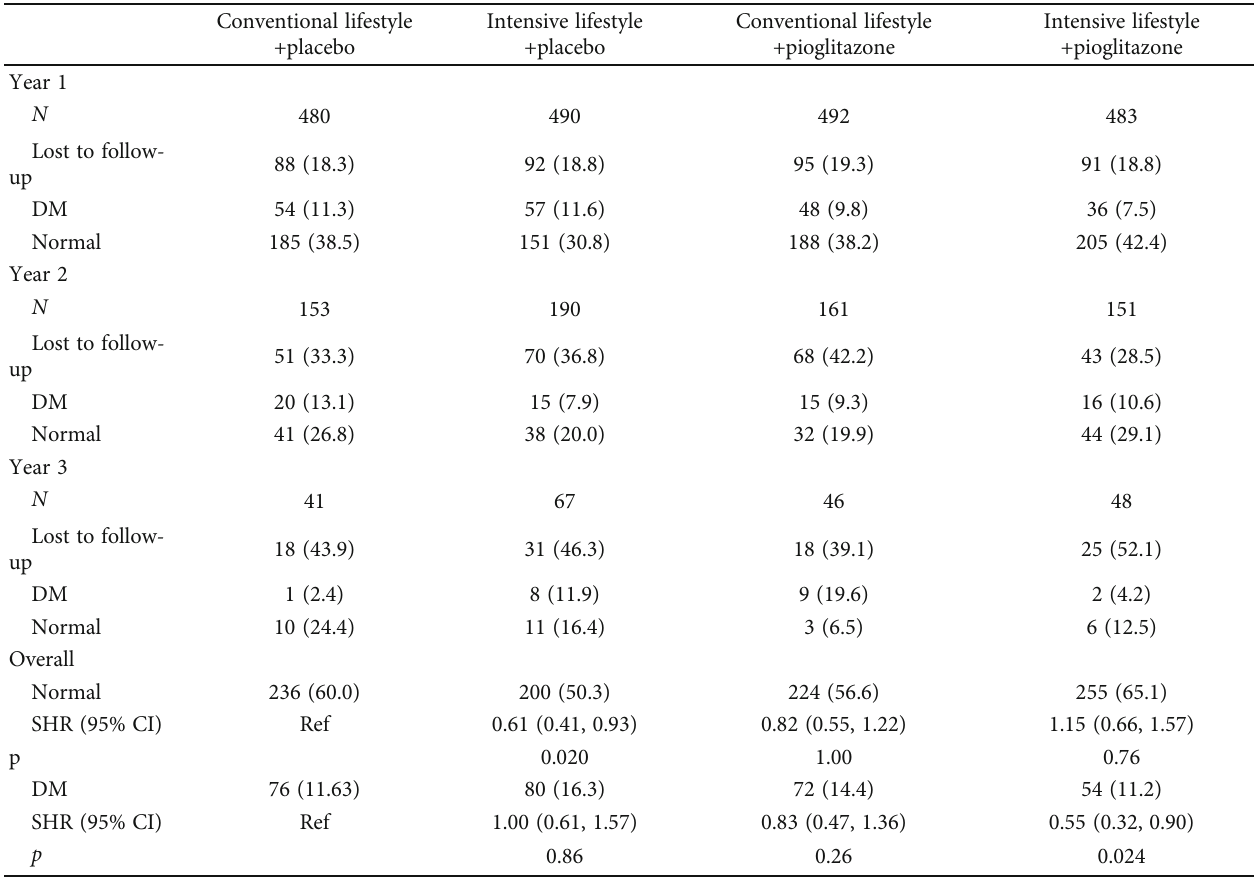
Table 2: Proportions of individual developing diabetes and reverting back to normoglycemic state at 1, 2, and 3 years of follow-up, by treatment groups and the odds ratio (95% CI) of the likelihood of reverting to normoglycemic state and developing diabetes during 3 years of follow-up in the three treatment groups, compared to the conventional+placebo